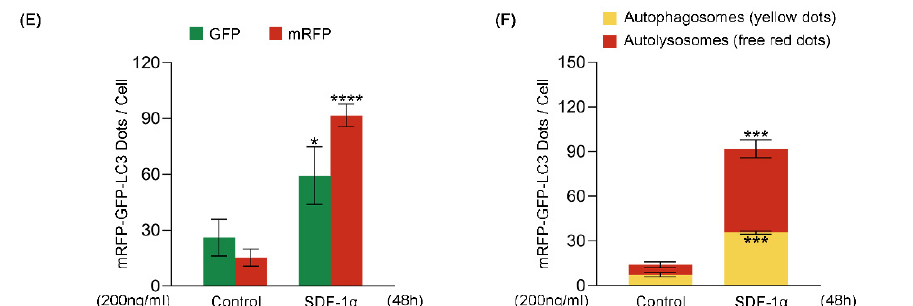
Figure 1. SDF-1 α promotes autophagy phenotype in chondrocytes. ( A ) Gene ontology (GO) enrichment based on RNA sequencing demonstrating autophagy-related biological processes (BP) in chondrocytes induced by SDF-1 α (200 ng/mL) for 48 h. ( B ) Representative TEM images showing that the number of autophagic vacuoles was increased in chondrocytes after treatment with 200 ng/mL SDF-1 α for 24 h. Red arrows indicate autophagic vacuole. ( C ) Quantitative analysis of the number of autophagic vacuoles shown in ( B ). We counted five cells from three independent experiments in each group to demonstrate the number of autophagic vacuoles. ( D ) mRFP-GFP-LC3 adenovirus double label assay indicating the increase of autophagy flux in chondrocytes after treatment with 200 ng/mL SDF-1 α for 48 h. Free red dots represent autolysosomes. Yellow dots represent autophagosomes. White arrows point to the autolysosome. We counted six cells from three independent experiments in each group to detect the changes in the levels of autophagy. ( E ) Quantitative analysis of the number of mRFP and GFP dots in chondrocytes shown in ( D ). ( F ) Quantitative analysis of the number of autophagosomes and autolysosomes in chondrocytes shown in ( D ). The data shown in ( A , B , D ) are based on three independent experiments ( n = 3). Data in ( C , E , F ) are presented as the mean ± SD, and the significance is based on two-tailed Student’s t -tests. * p < 0.05; *** p < 0.001; **** p <